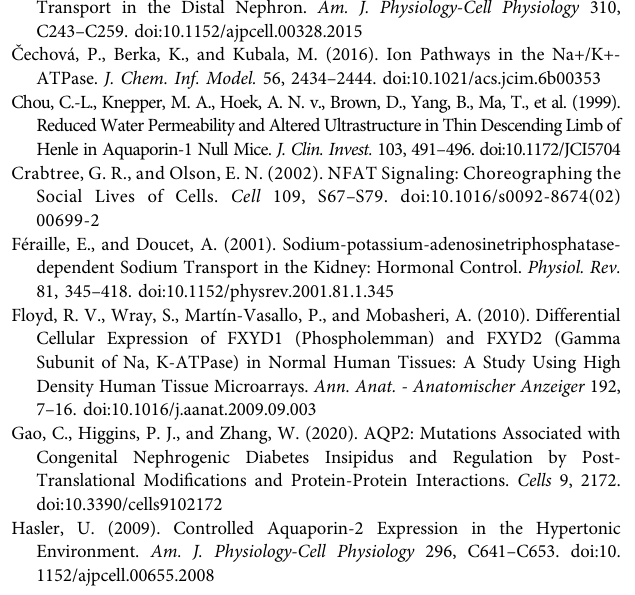
Supplementary Figure S1 | Sequence length distribution of the unigene sequences. The X-axis shows the range of lengths of the transcript sequences. The Y-axis shows the number of unigenes. Supplementary Figure S2 | Full western blotting image of some proteins. ADCY3 and thecorresponding GAPDH blottingimages (A) ; NFATc1 and thecorresponding GAPDH blottingimages (B) ; NF-kB1 andthecorresponding GAPDH blottingimages (C) ; HIF1A and the corresponding GAPDH blotting images (D) ; SLC4A4 and the corresponding GAPDH blottingimages (E) ; ATP1A1 andthecorrespondingGAPDH blotting images (F)